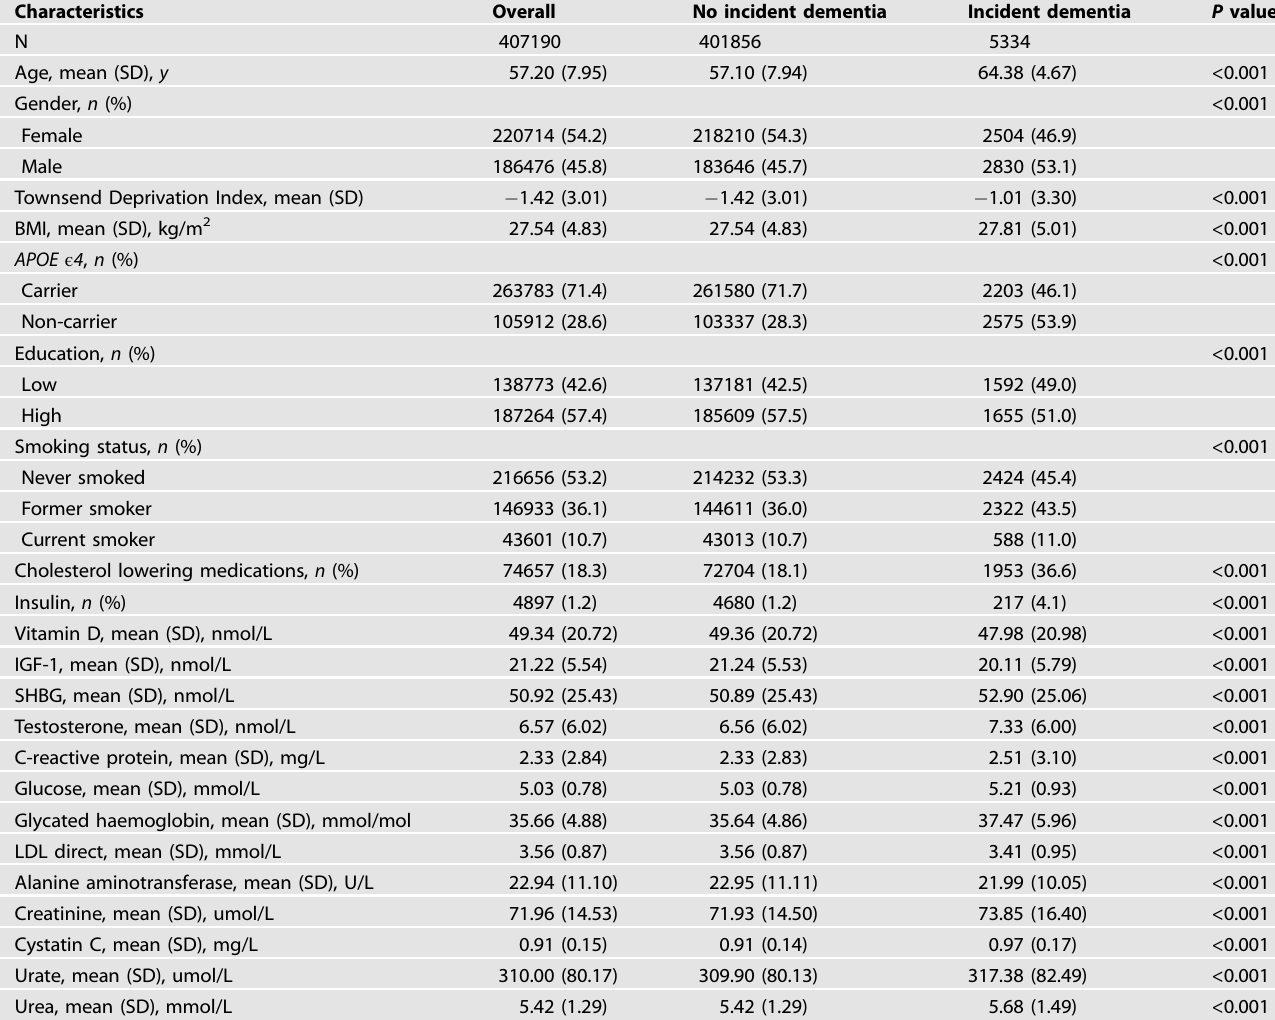
Table 1. Baseline characteristics of study participants by incident dementia